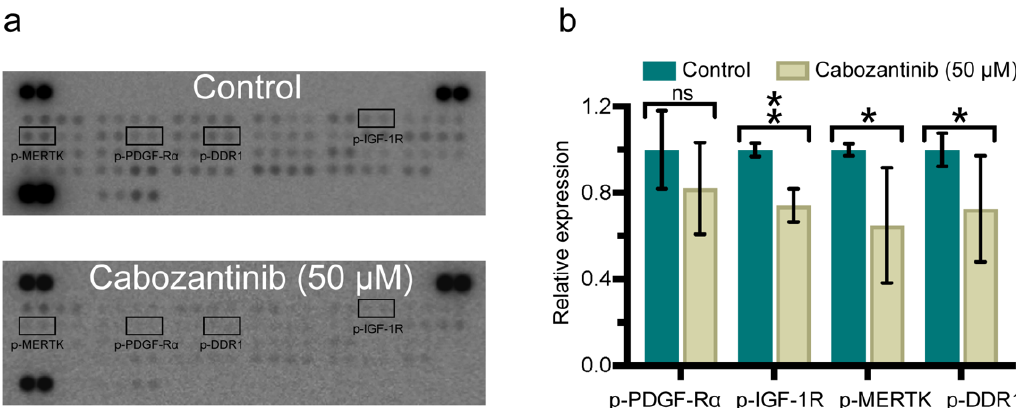
Figure 5. Multiple phosphorylated-receptor tyrosine kinases (p-RTKs) are downregulated in H1 cells after cabozantinib treatment. ( a ) Representative images of RTK arrays that were incubated with lysates of H1 cells untreated (control) or treated with 50 µ M cabozantinib for 48 h. Darker spots represent the higher expressional level of the p-RTKs. In each array, each p-RTK is presented by two spots. ( b ) Graphic presentation of the expression levels of selected p-RTKs normalized against the reference spots and presented as a ratio against the controls. ns: not significant; *: p < 0.05; **: p <